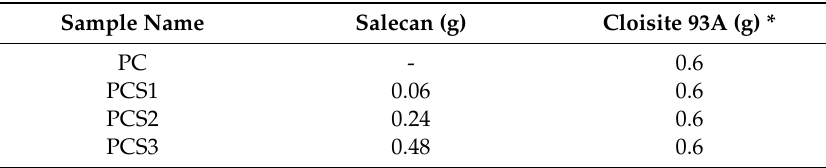
Table 1. Nomenclature of the synthesized